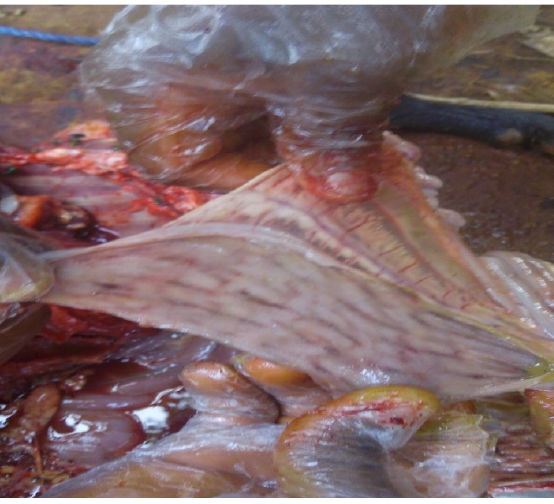
Fig. 6. Discontinuous streaks of congestion (Zebra-markings) in the mucosa of the colon and rectum